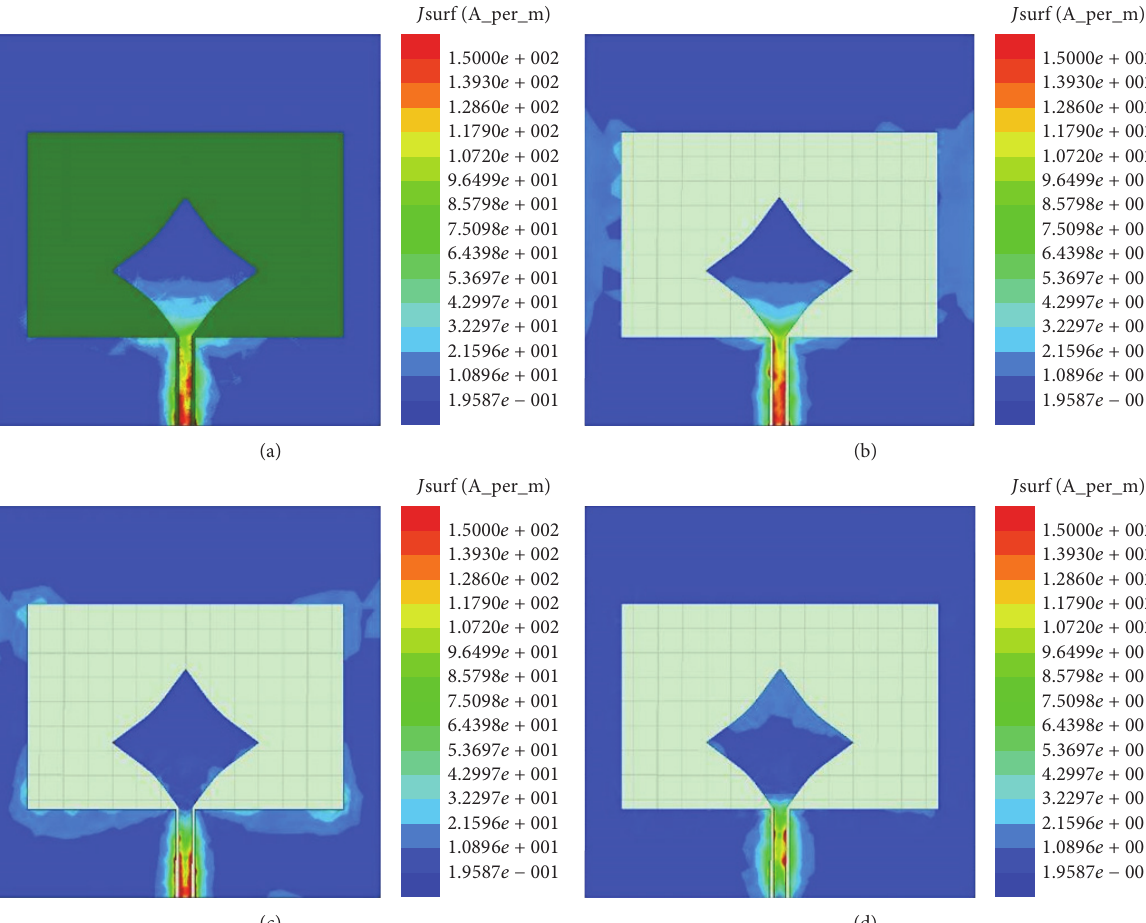
Figure 9: Simulated current distributions at (a) 2.8 GHz, (b) 3.6 GHz, (c) 7 GHz, and (d)